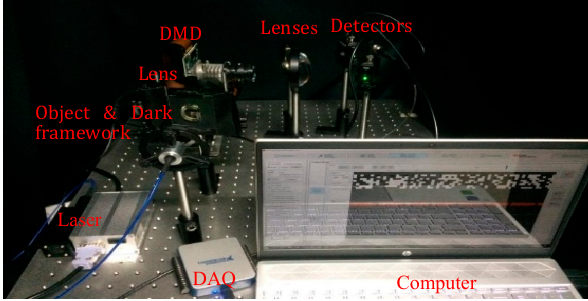
Figure 2. Experimental setup implemented in our lab environment.